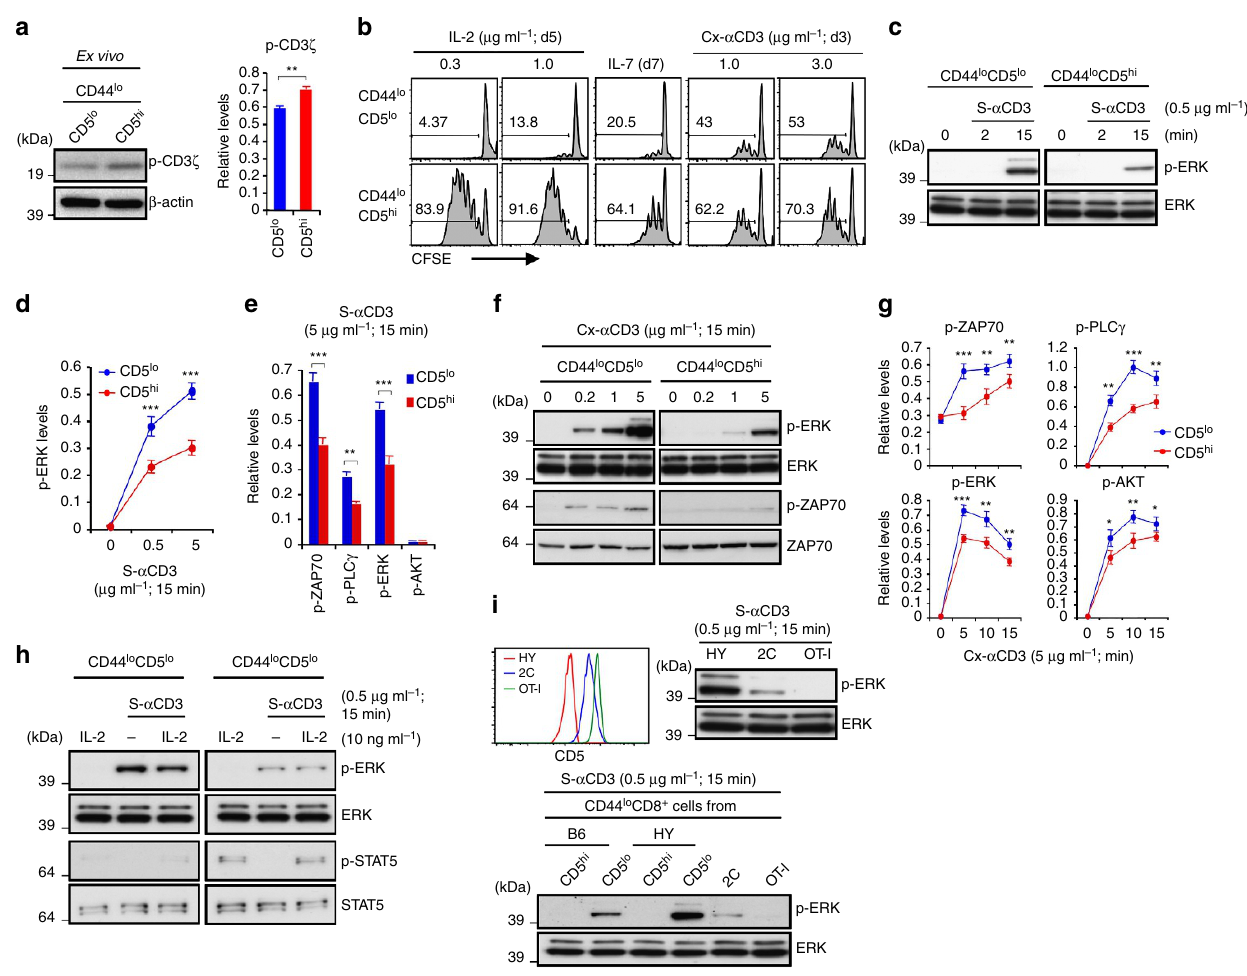
Figure 1 | TCR sensitivity of CD5 lo versus CD5 hi na ı¨ ve CD8 þ T cells. ( a ) Levels of tyrosine-phosphorylated CD3 z chain (p-CD3 z ; 21kDa) in freshly isolated CD5 lo and CD5 hi B6 naı¨ve (CD44 lo ) CD8 þ Tcells (relative to b -actin; mean ± s.d.). ( b ) Proliferation of CFSE-labelled CD5 lo and CD5 hi B6 naı¨ve CD8 þ Tcells after incubation with IL-2, IL-7, or cross-linked anti-CD3 (Cx- a CD3) mAb. ( c – e ) ERK phosphorylation ( c ) and densitometric levels (relative to total ERK; d or b -actin; e ) of phosphorylated ERK ( d , e ), ZAP-70 ( e ), PLC g ( e ), and AKT ( e ) in CD5 lo and CD5 hi B6 naı¨ve CD8 þ Tcells after incubation with soluble anti-CD3 (S- a CD3) mAb (graphs in d and e show mean ± s.d.). ( f , g ) Phosphorylation of ERK and ZAP70 ( f ) and levels of phosphorylated ZAP-70, PLC g , ERK and AKT (relative to b -actin; mean ± s.d.) ( g ) in CD5 lo and CD5 hi B6 naı¨ve CD8 þ T cells after incubation with Cx- a CD3 mAb. ( h ) Phosphorylation of ERK and STAT5 in CD5 lo and CD5 hi B6 naı¨ve CD8 þ Tcells after S- a CD3 mAb incubation with or without IL-2. ( i ) CD5 levels by flow cytometry (top left) and S- a CD3 mAb-induced ERK phosphorylation by Western blot (top right) in naı¨ve CD8 þ Tcells from HY, 2C and OT-I TCR Tg mice (top and bottom) or CD5 lo and CD5 hi naı¨ve CD8 þ Tcells from B6 and HY mice (bottom); note that CD5 hi HYcells are TCR-clonotype negative. Data are representative of at least four ( a , c - g ) and three independent experiments ( b , h , i ). Unpaired Student’s t -test was used for the statistical analysis. * P o 0.05; ** P o 0.005; *** P o 0.0005.